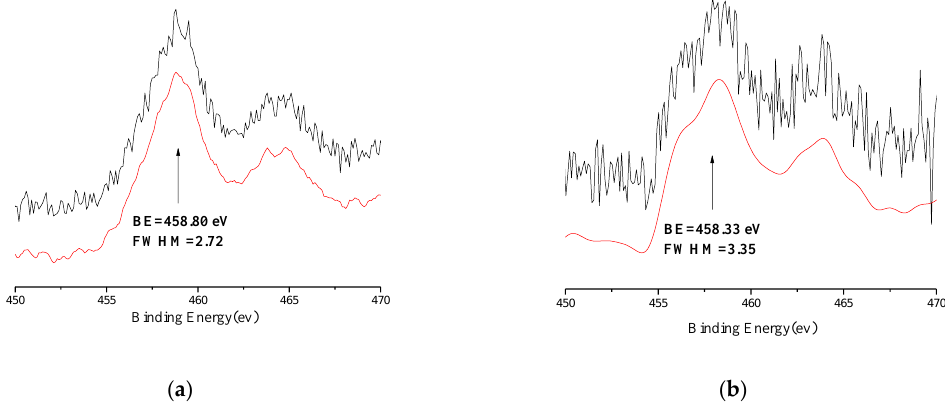
Figure 5. XPS spectra of Ti 2P3/2 region of Cat-1 ( a ) and Cat-3 ( b ).